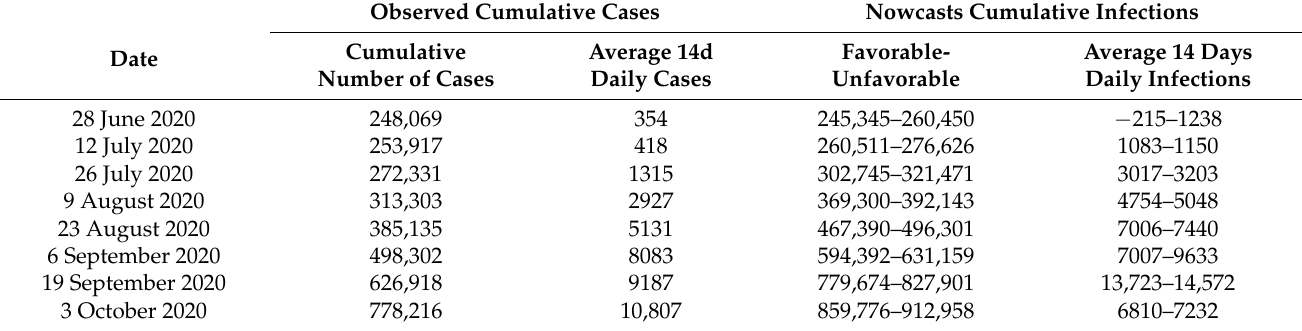
Table 4. Nowcast